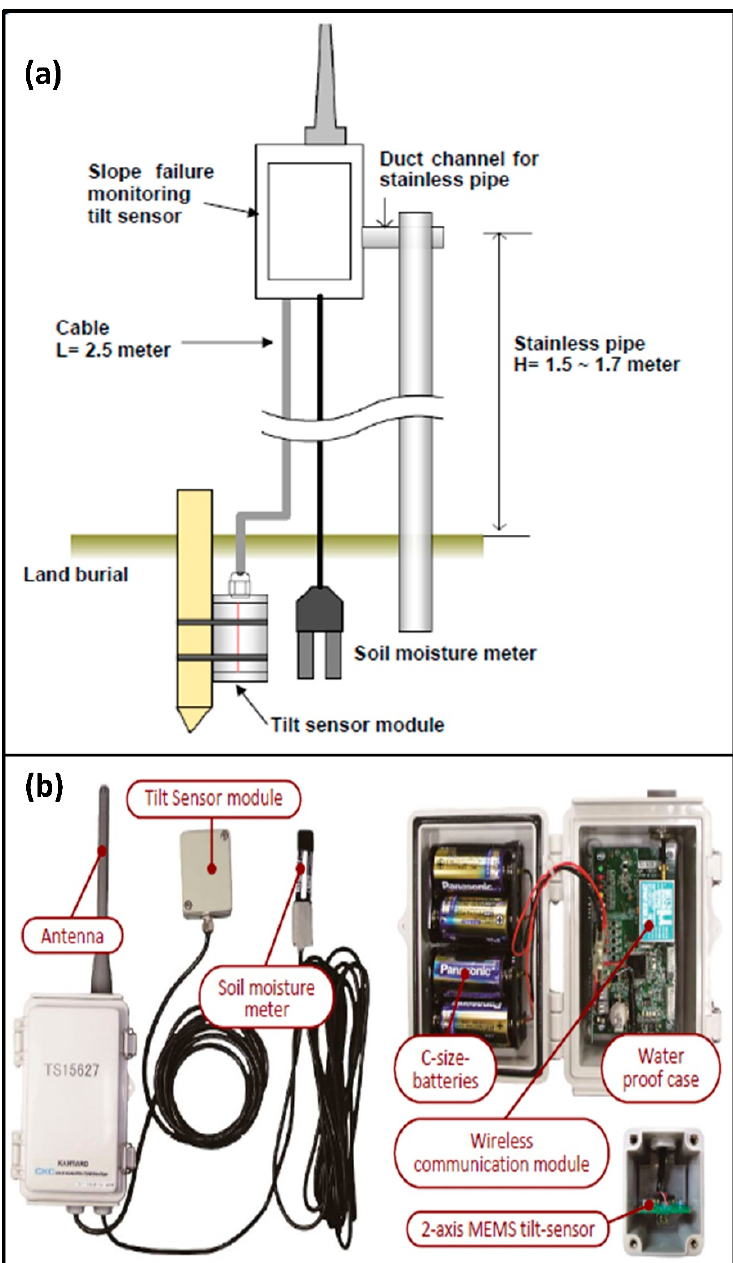
Figure 4. Details of tilt sensor: ( a ) schematic arrangement of the sensor set up and ( b ) components of a tilt sensor unit.